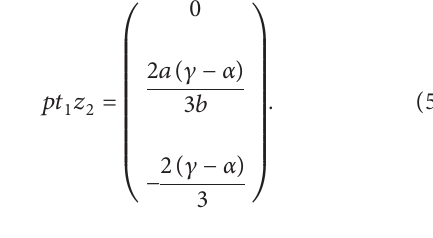
is tangent to SW are in a red dotted line, while the points where the vector field of P 2 23 and R are in 1 2